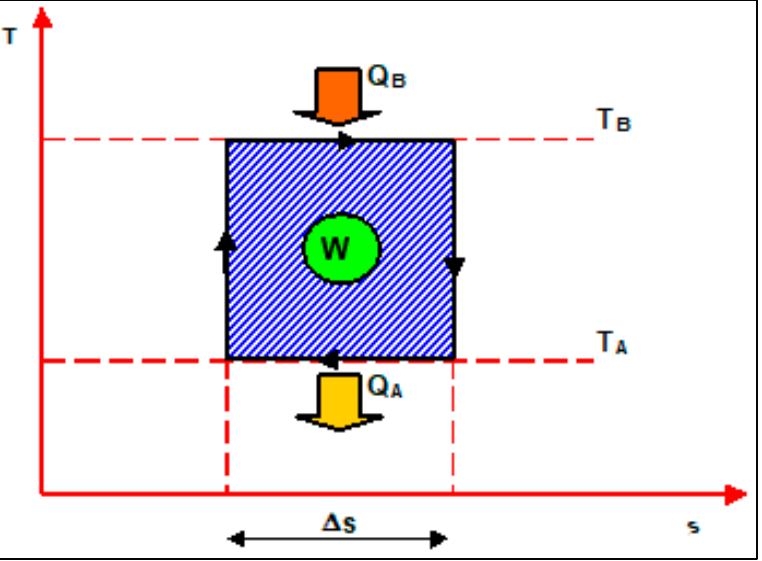
Figure 3. Carnot cycle shows the transformation of a higher temperature heat source into work in the shaft of a thermal machine and the rejection of the waste heat to the environment (Adapted from [7]). It is also necessary to have a heat recovery system that will provide steam and hot water for various uses in an applied production